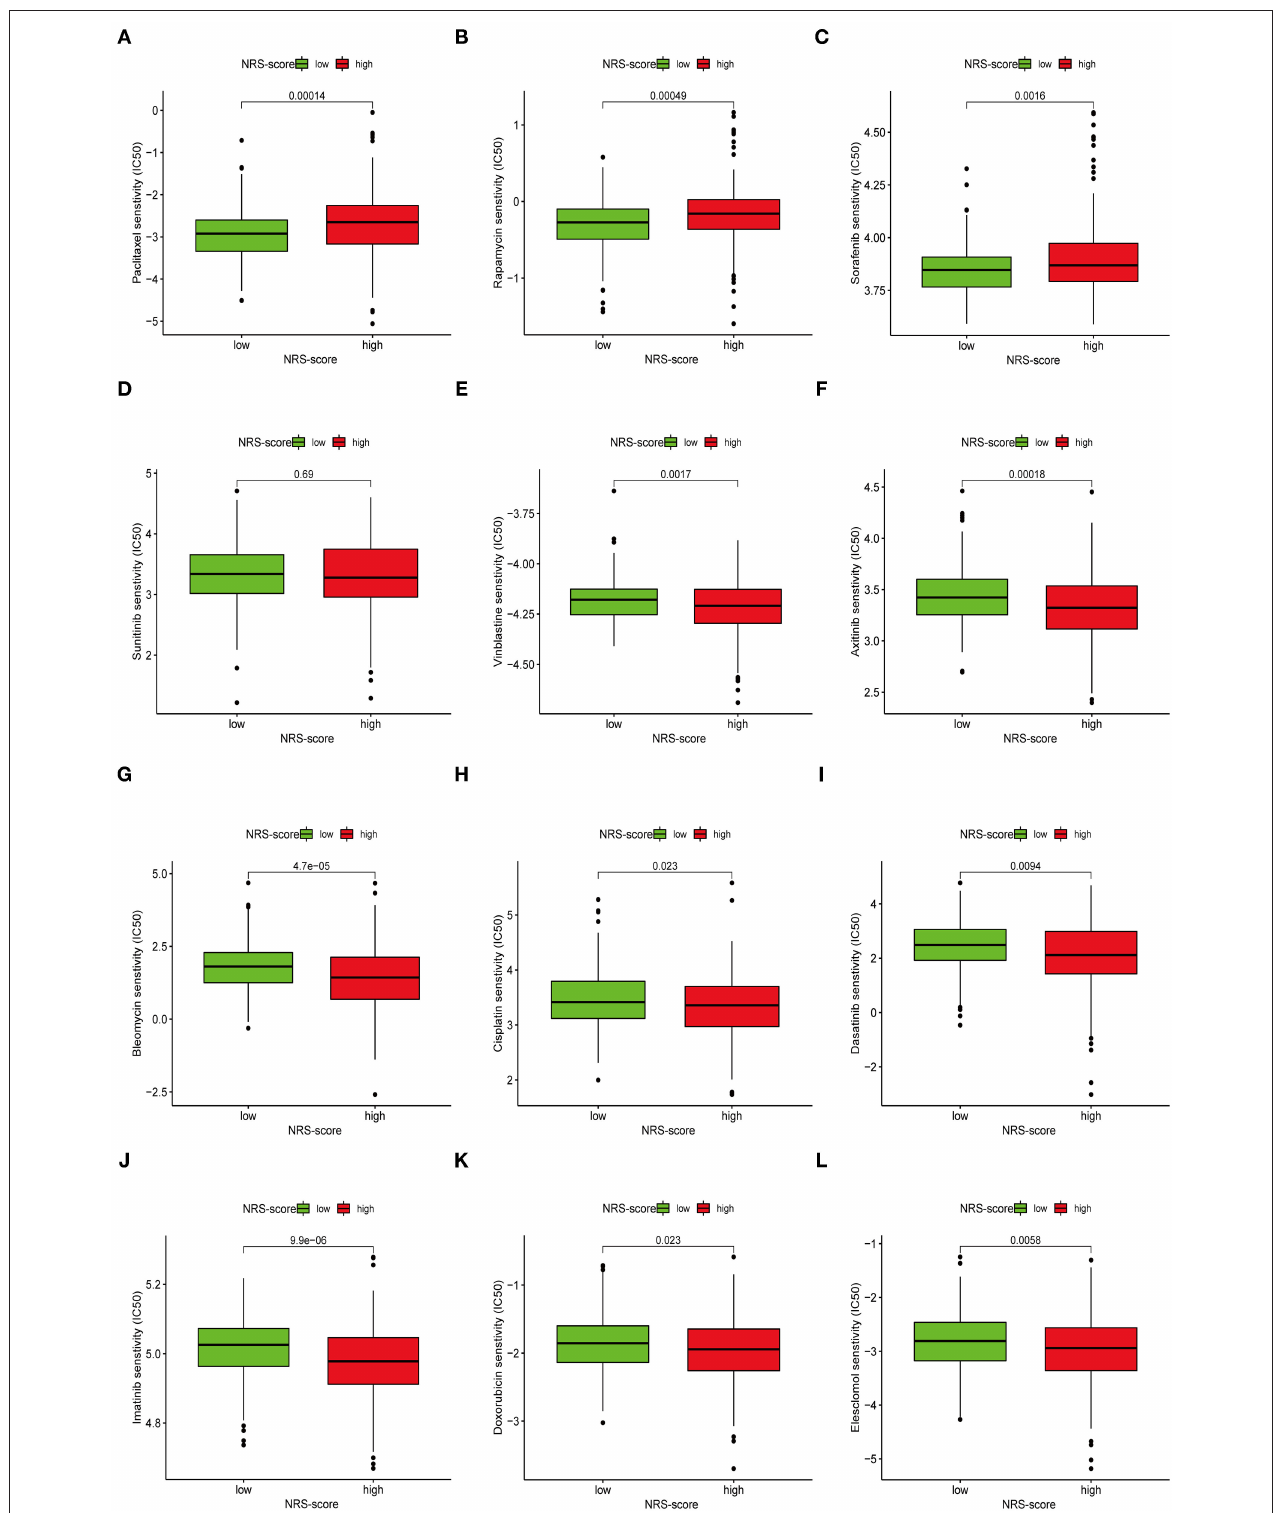
FIGURE 11 | Assessment of chemotherapeutic efficacy in patients from different NRS-score groups. The sensitivity to chemotherapeutic drugs was represented by the half-maximal inhibitory concentration (IC50) of chemotherapeutic drugs. (A) Paclitaxel, (B) Rapamycin, (C) Sorafenib, (D) Sunitinib, (E) Vinblastine, (F) Axitinib, (G) Bleomycin, (H) Cisplatin, (I) Dasatinib, (J) Imatinib, (K) Doxorubicin, (L) Elesclomol.